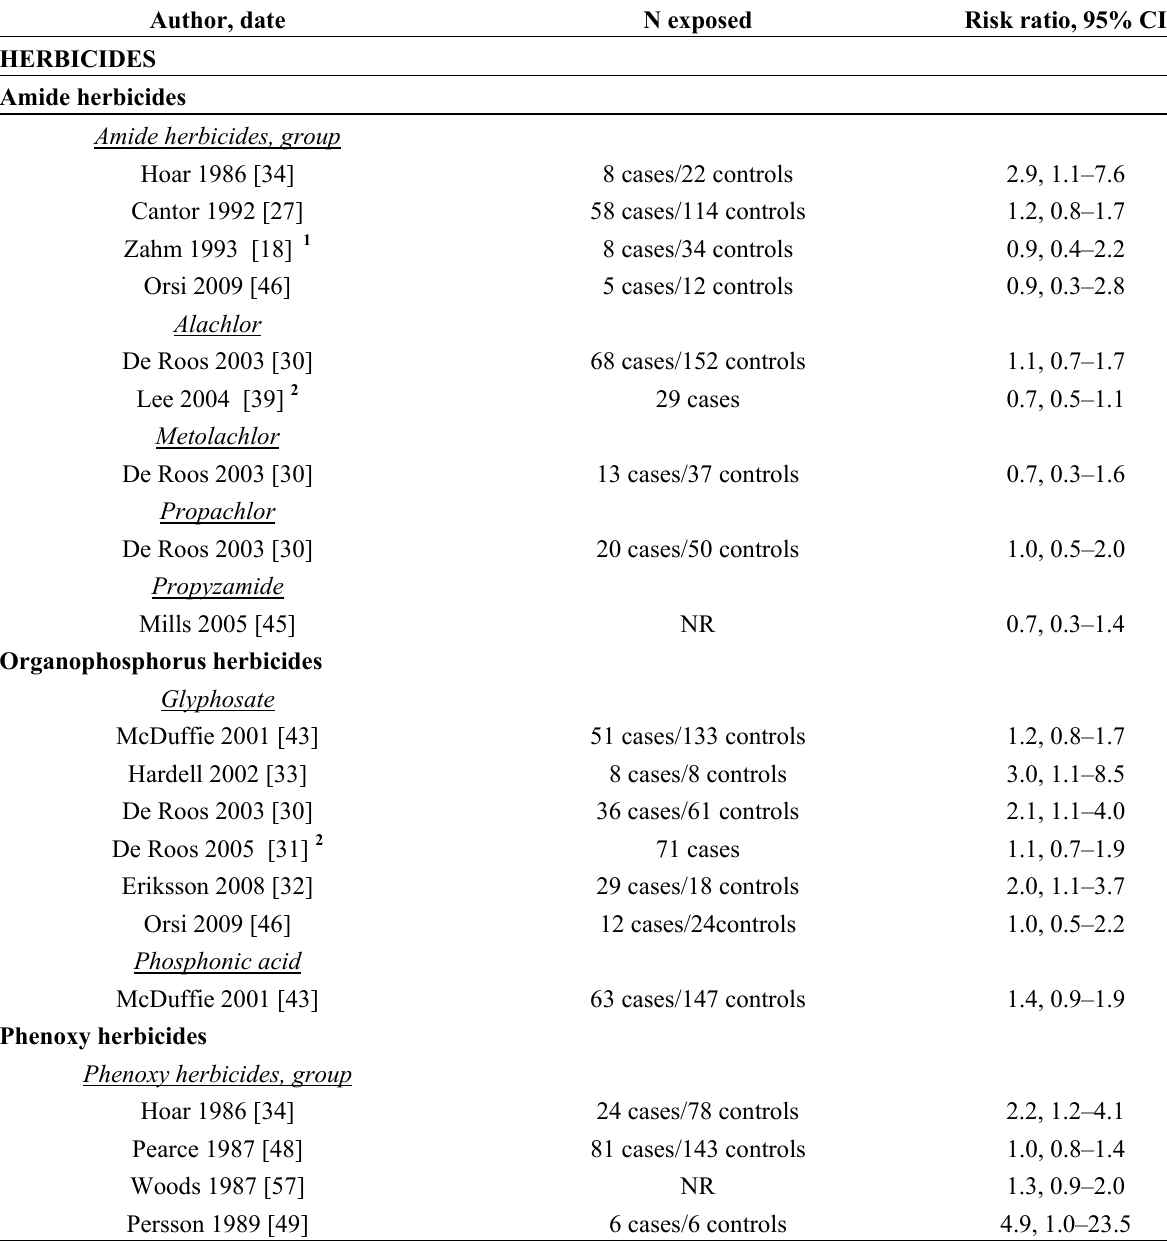
Table 4. Effect estimates from papers that investigated associations between non-Hodgkin lymphoma and herbicide, fungicide, and insecticide exposures, categorized